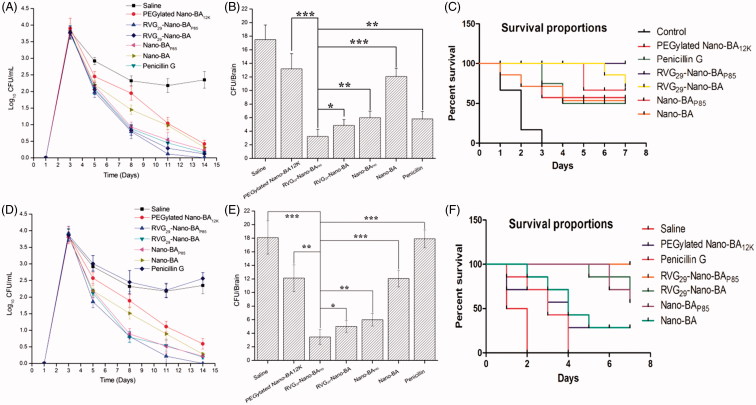
Colony formation unit of S. pneumonia ATCC 49619 in CSF of the mice without any treatment (the negative control group) or treated with Nano-BAs or Penicillin G for various periods of time (A). Quantitative counts of S. pneumonia ATCC 49619 per gram of brain tissues of the mice without any treatment (the control group) or treated with Nano-BAs or Penicillin G for 14 days (B). Survival rate of the PM mice infected with S. pneumonia ATCC49619 after treated with Saline, PEGylated Nano-BA12K, Penicillin G, RVG29-Nano-BAP85, RVG29-Nano-BA, Nano-BAP85, and Nano-BA, respectively (C). Colony formation unit of S. pneumonia 16167 in CSF of the mice without any treatment (the negative control group) or treated with Nano-BAs or Penicillin G for various periods of time (D). Quantitative counts of S. pneumonia 16167 per gram of brain tissues of the mice without any treatment (the control group) or treated with Nano-BAs or Penicillin G for 14 days (E). Survival rate of the PM mice infected with S. pneumonia 16167 after treated with Saline, PEGylated Nano-BA12K, Penicillin G, RVG29-Nano-BAP85, RVG29-Nano-BA, Nano-BAP85, and Nano-BA, respectively (F). Values are mean ± SD of six independent observations. *p < .05, **p < .01, ***p < .001, significance represents RVG29-Nano-BAP85 vs. RVG29-Nano-BA, Nano-BAP85, Nano-BA, and PEGylated Nano-BA12K.